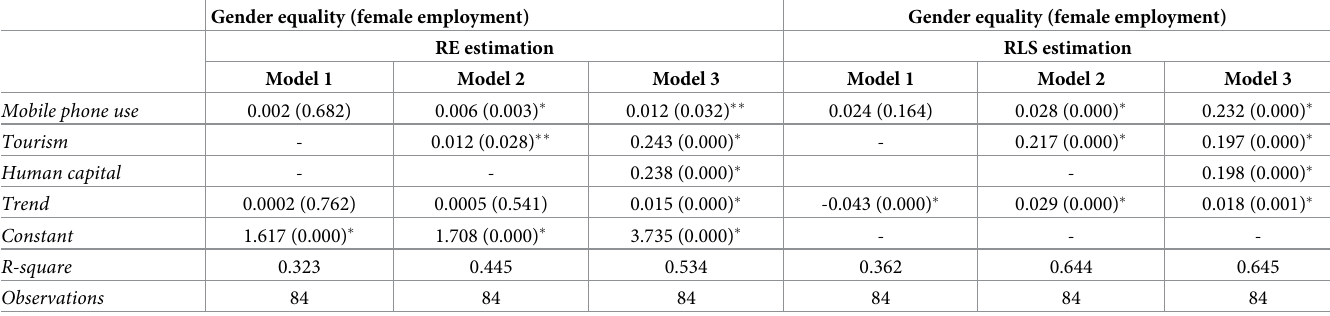
Table 7. Results of ICT and gender (female employment).